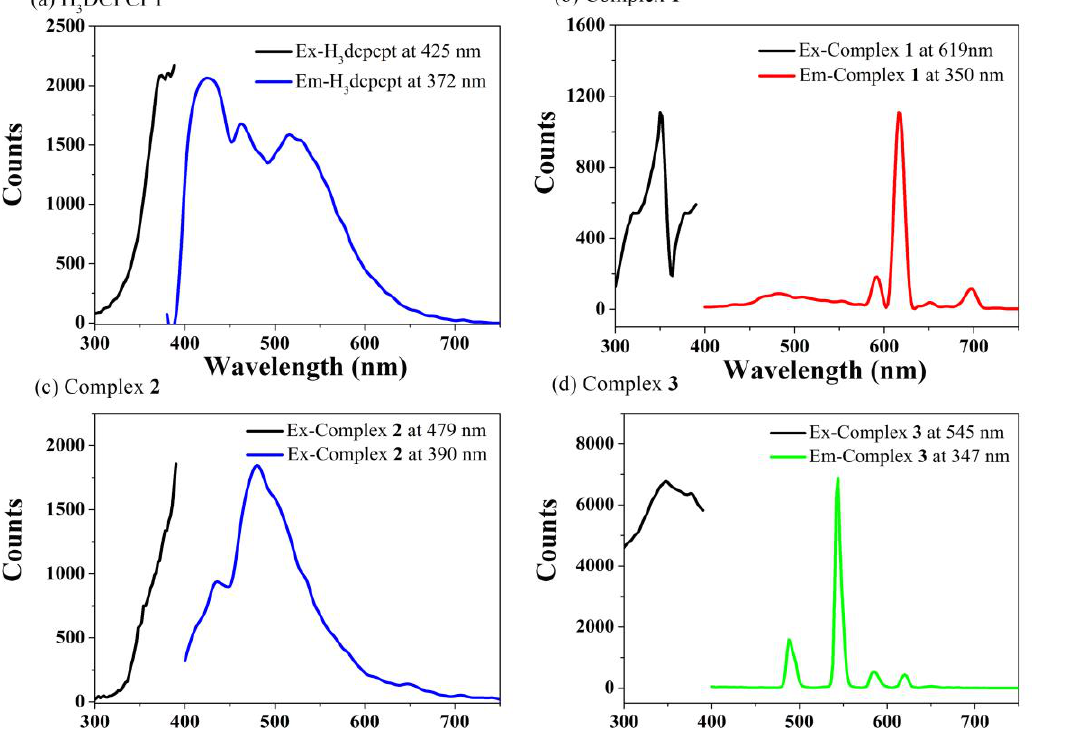
Figure 2. Solid-state photoluminescent spectra of ( a ) H 3 dcpcpt, ( b ) 1 , ( c ) 2, and ( d ) 3 . ( e ) Simplified schematic diagram of energy transfer process. ( f ) Luminescent spectra and optical photographs of complex 4 in solid state and well-dispersed 0.01 M aqueous solution under the excitation of 320 nm. 3.3. White-Light Emission of Complex 4 Based on the isomorphism of complexes 1 – 3 exhibiting three primary luminescent colors, it would be probable to construct white-light-emitting materials by meticulously tuning the stoichiometric ratio of Eu 3+ , Gd 3+ , and Tb 3+ ions. As a result, the corresponding three-component Ln- MOF, [Eu 0.41 Gd 0.42 Tb 0.17 (dcpcpt)(H 2 O)] n ( 4 ), is in-situ synthesized, with a 2:2:1 feed ratio of Eu 3+ :Gd 3+ :Tb 3+ ions. The accurate molar ratio of 41:42:17 is yielded by inductively coupled plasma (ICP) analysis (Table S1). PXRD, FT-IR, UV-vis, and TG-DSC reveal that complex 4 is isomorphic with 1 – 3 (Figures S1 and S3–S5). According to Figure 2f, a white-light emission, with CIE coordinates of (0.330, 0.338), which is close to those of pure white light (0.333, 0.333), emerges upon excitation at 320 nm. In addition, the luminescence property of complex 4 remains intact upon dissolving to form a well-dispersed 0.01 M aqueous suspension. Luminescence life-time data of complex 4 implies the existence of energy transfer from Tb 3+ to Eu 3+ ion (Table S2). To quantify the efficiency of this inter-metallic transfer ( η ET ), the relationship ( η ET